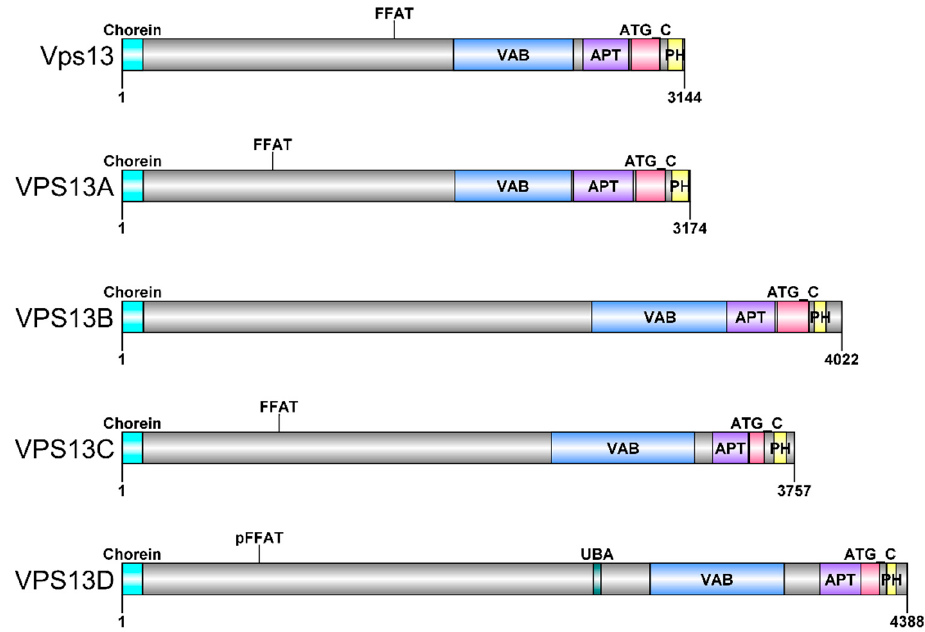
Figure 2. The schematic representation of the domain structure of VPS13 proteins. The domains of S. cerevisiae Vps13 and human VPS13A-D proteins; Chorein domain. VAB, Vps13 adaptor binding/WD40 domain; APT, APT1 domain; ATG_C, autophagy-related protein 2 C-terminal